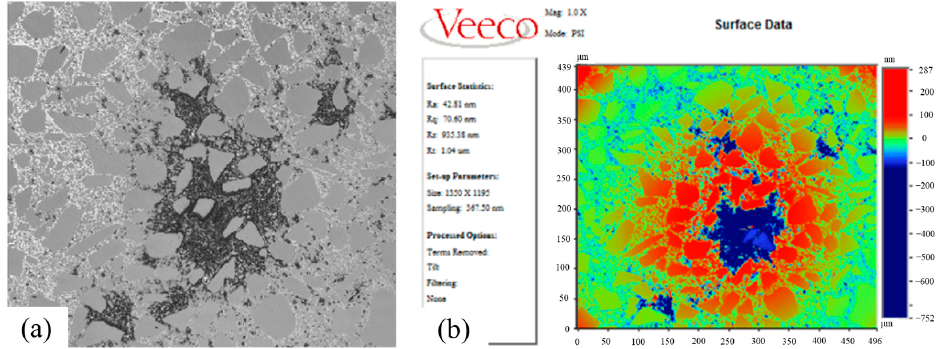
Figure 9. Microscopic imaging of the surface of externally supplied machining components. ( a ) Micrograph; ( b ) roughness.